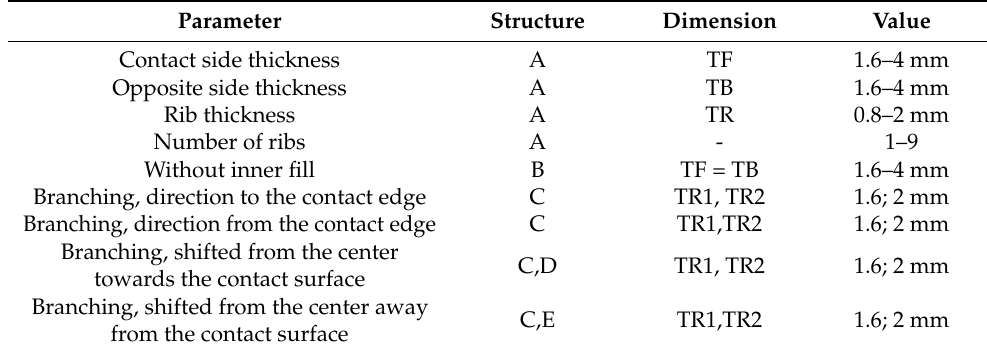
Figure 2. Filling patterns structure: (a) Straight ribs; (b) No internal filling; (c) Branched ribs with branching in the middle; (d) Branched ribs with branching shifted to the left side; (e) Branched ribs with branching shifted to the right side. Table 1. Parameters of tested